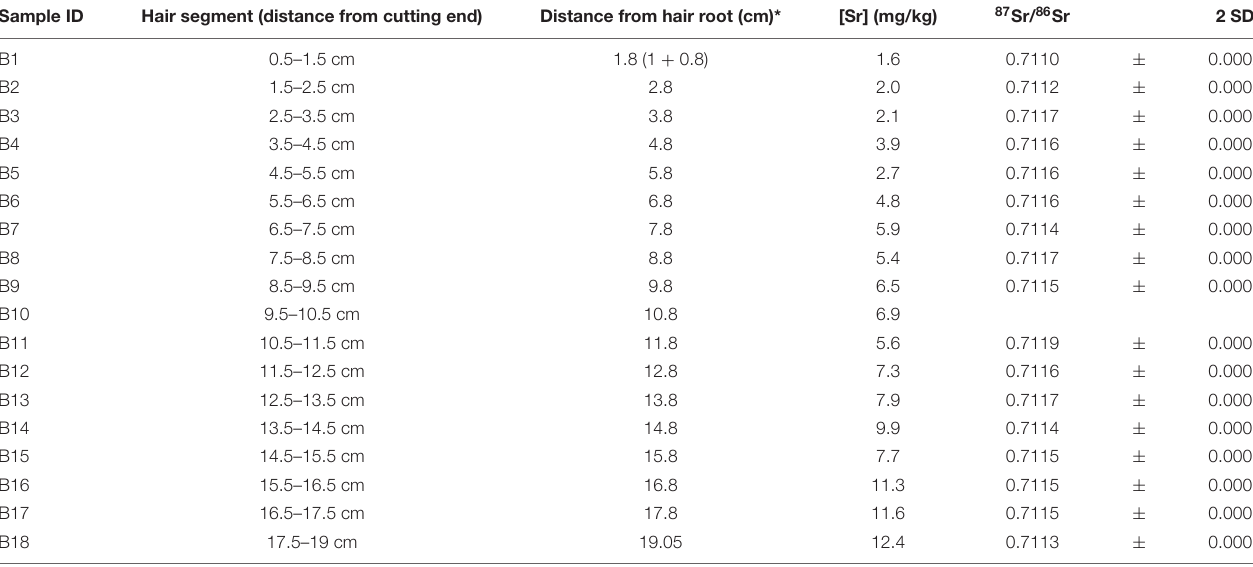
TABLE 3 | [Sr] and 87 Sr/ 86 Sr ratios in hair